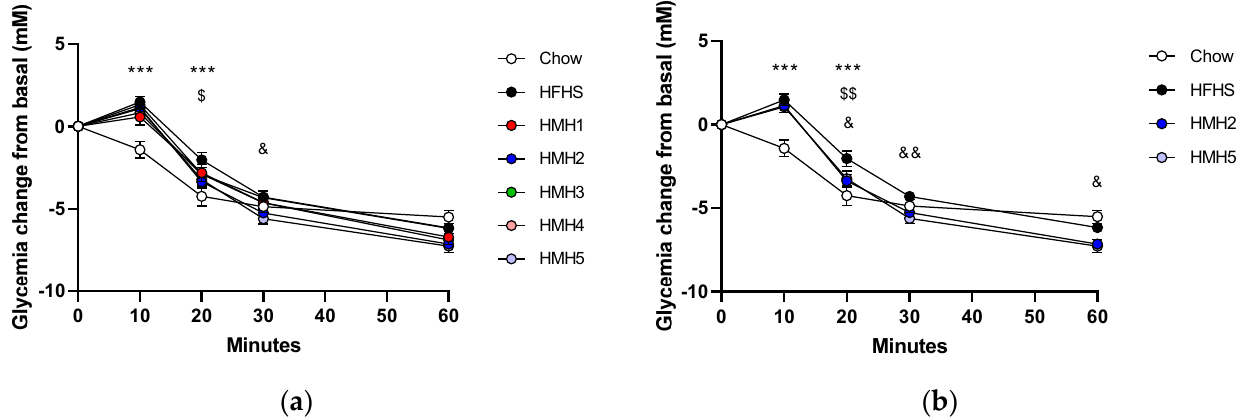
Figure 3. Impact of HMH supplementation in mice fed with HFHS on insulin tolerance during the ITT. Glycemic variation curve as a function of time ( a ) to statistically compare the different supplementations with HFHS ( b ) focus more specifically on the statistics of HMH2 and the resulting product HMH5. *** p < 0.001 Chow vs. HFHS, $ p < 0.05 HFHS vs. HMH2, $$ p < 0.01 HFHS vs. HMH2, & p < 0.05 HFHS vs. HMH5, && p < 0.05 HFHS vs. HMH5.